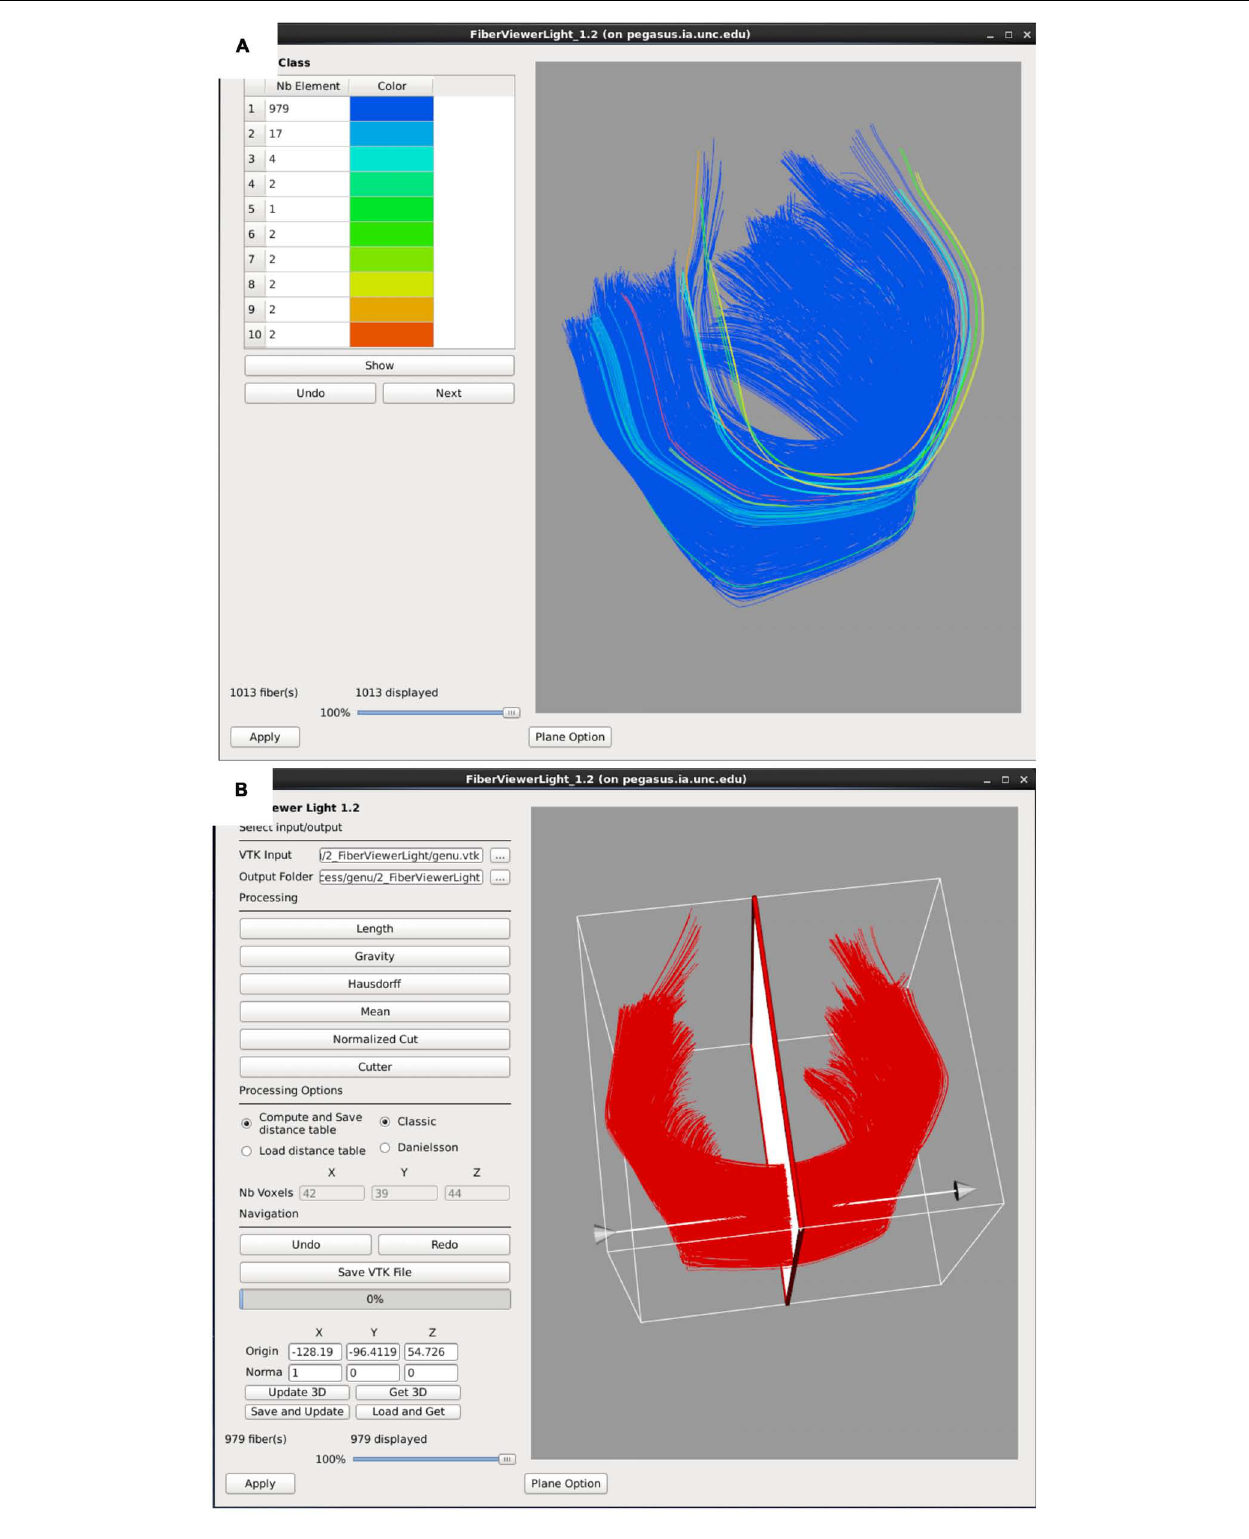
FIGURE 6 | FiberViewerLight clustering, cleaning, and plane creation. (A) Example of genu fiber clustering based on the center of gravity. (B) In the left panel all of the fiber clustering algorithms are visible, as well as the different